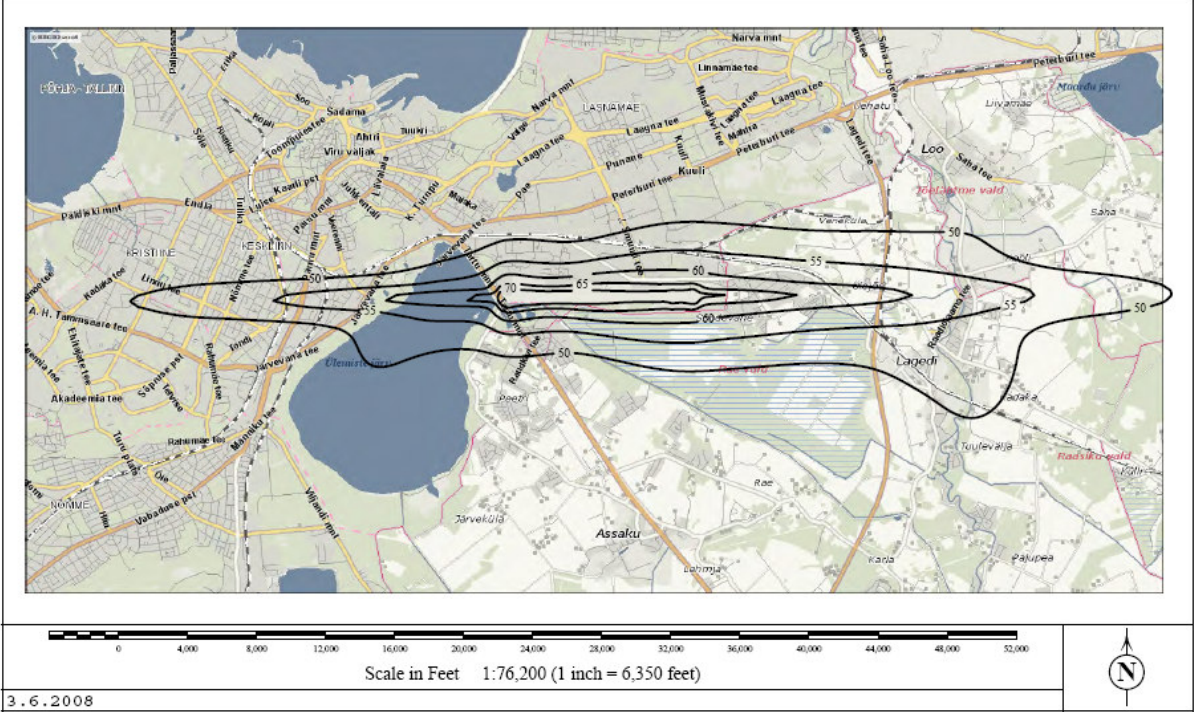
Fig 4. Tallinn Airport. Noise map according to Directive 2002/49/EC. Lden noise contours. 2006 average